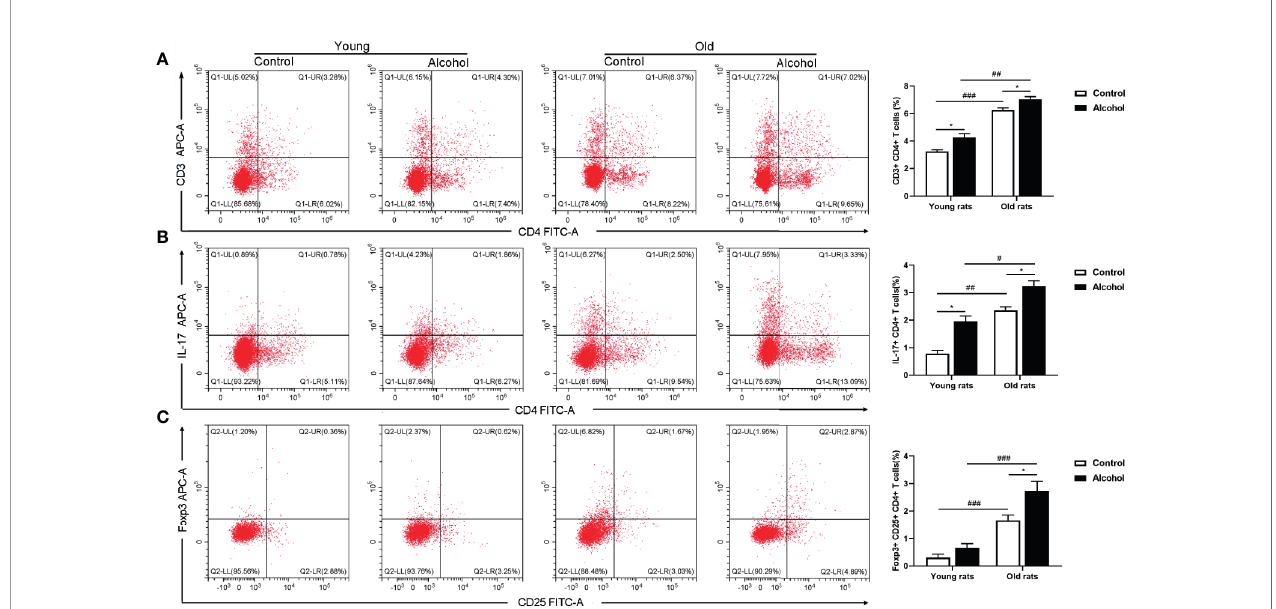
FIGURE 3 | Effects of alcohol on activation of CD4 T lymphocyte in bone marrow of young and old rats. (A) The proportion of CD3 + CD4 + T cells in bone marrow was detected by fl ow cytometry; (B) The proportion of Th17 in bone marrow; (C) The proportion of Treg in bone marrow. Data were shown as mean ± SD. n = 6, * P < 0.05, compared with control of the same age; # P < 0.05, ## P < 0.01, ### P < 0.001, the same group compared with young